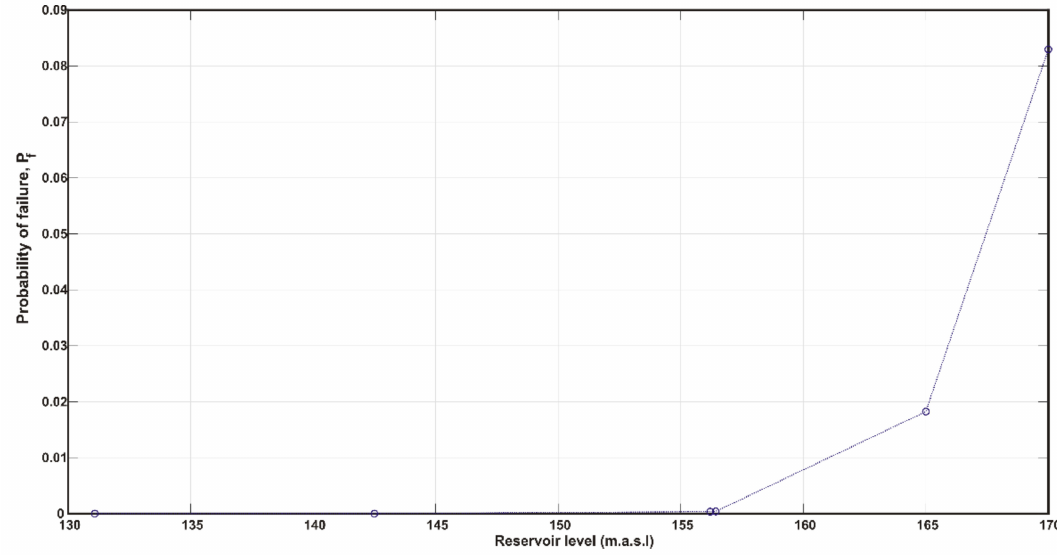
Figure 13. Estimation of the probability of failure by sliding for different reservoir levels applying the Monte Carlo simulation